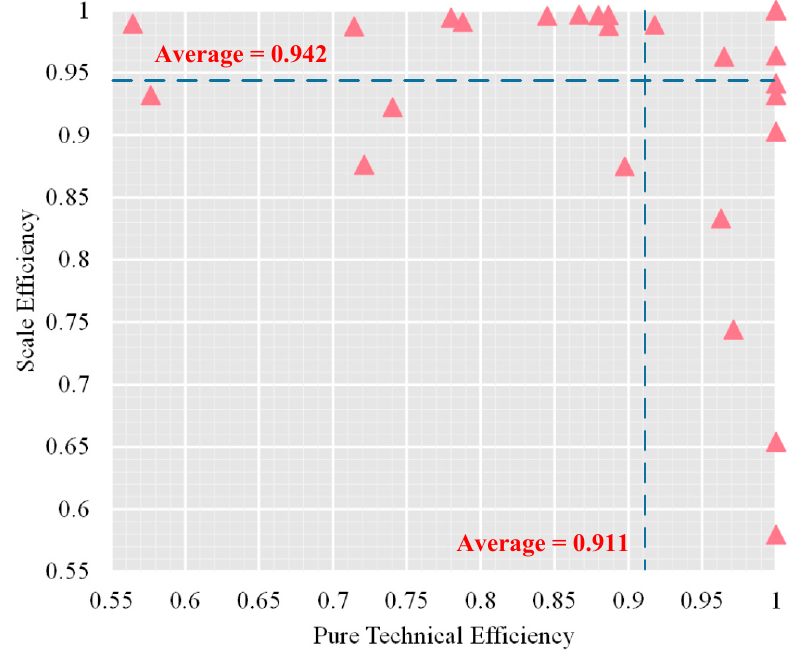
Figure 10. The pure technical efficiency and scale efficiency of 34 Chinese LED energy enterprises in 2019.